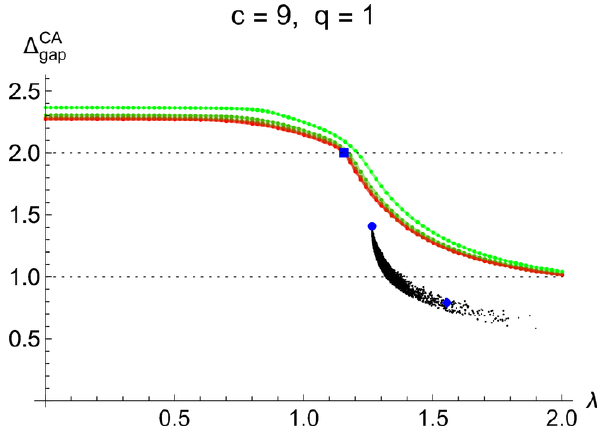
Figure 12. Upper bounds on the gap in the CA channel (cid:1) CA to red curves are the numerical bounds obtained from conformal bootstrap, in increasing derivative orders 8, 12, 16, 20, 24. The black dots are randomly sampled values of ( (cid:21); (cid:1) CA CFT, in the absence of B -(cid:12)eld. The blue circle dot marks the maximal (cid:1) CA square marks the large volume limit of the quintic that sits at the kink of the bounding curve. The blue diamond (buried in the black dots) marks the 3 5 Gepner model, which has (cid:1) CC